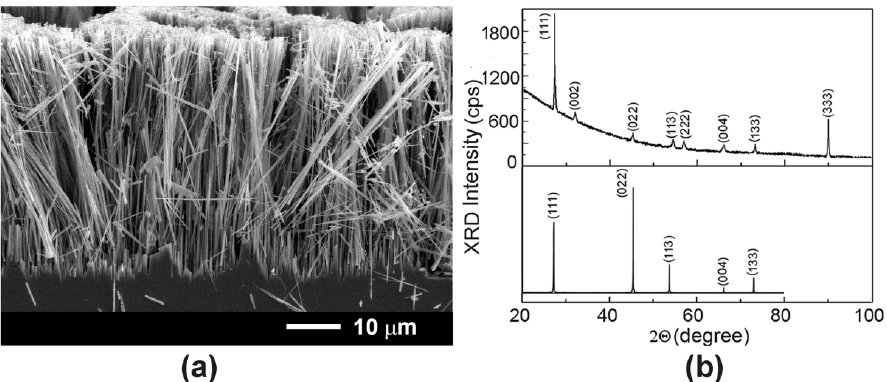
Figure 2. ( a ) Cross ‐ section SEM image of a GaAs nanowire array produced by anodizing a GaAs substrate with (111)B crystallographic orientation; ( b ) XRD analysis of a GaAs nanowire array (up ‐ per part), compared to a database XRD fingerprint (lower part).